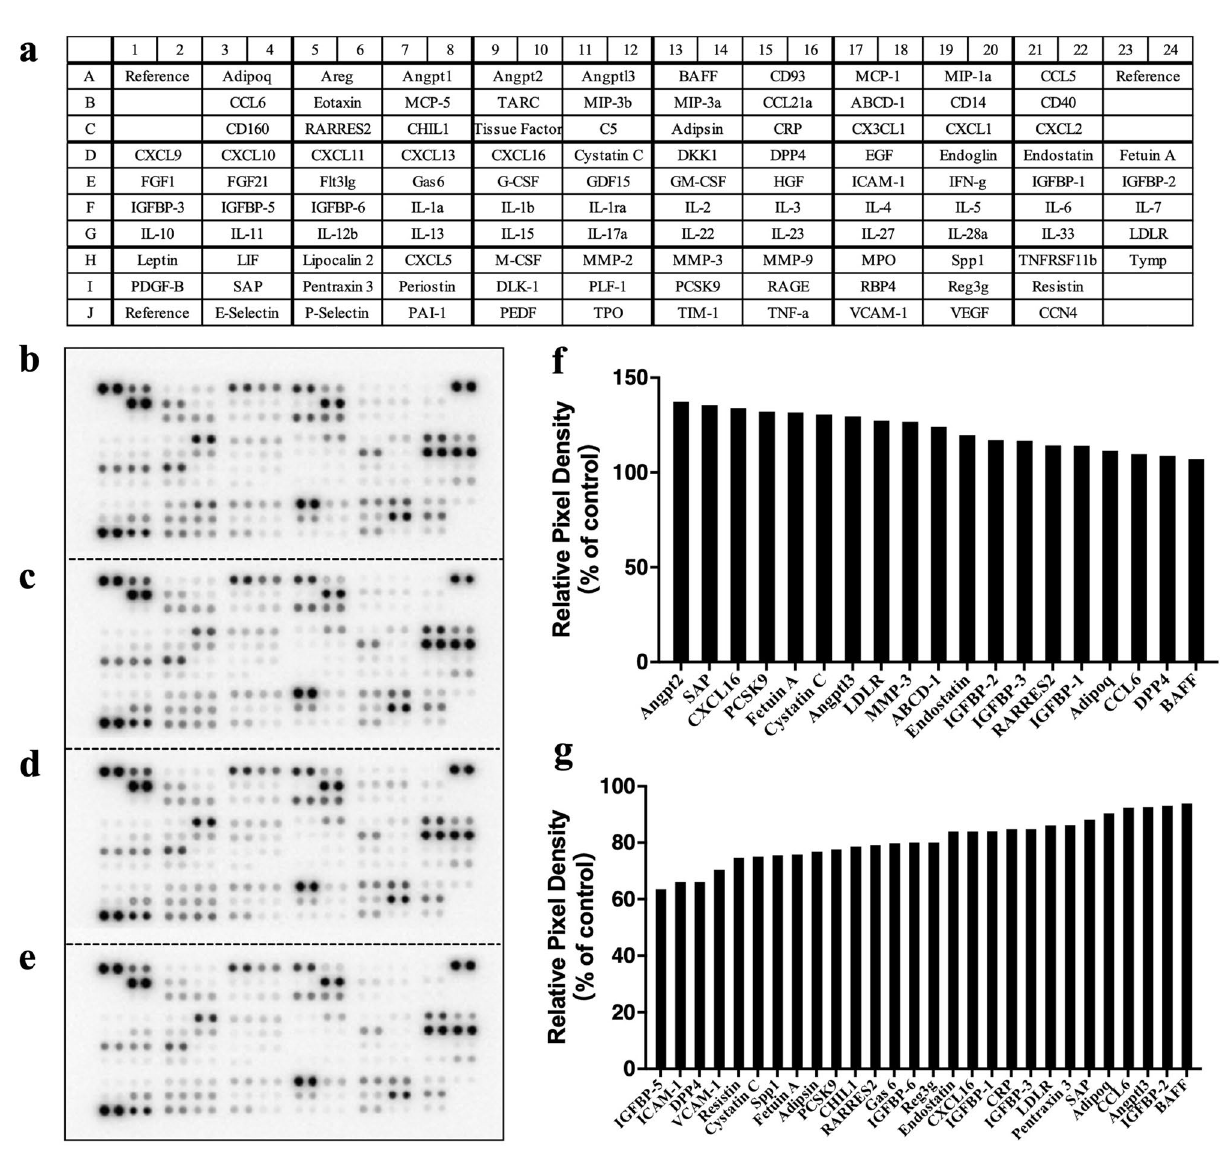
Figure 4. Cytokine array screening of mice serum infused with GIP_HUMAN[22–51] for 4 weeks. ( a ) Layout of antibody arrays and abbreviated names of the 111 cytokine/chemokine probes, adapted from the manufacturer’s information. ( b – e ) Complete hybridisation signals after probing with serum samples obtained from ApoE−/− mice infused for 4 weeks with saline alone ( b ), GIP_HUMAN[22–51] ( c ), combined infusion with GIP_HUMAN[22–51] and anti-GIP_HUMAN[22–51] IgG ( d ), or anti-GIP_HUMAN[22–51] IgG ( e ). ( f , g ) Quantified signal intensities of the respective serum proteins in mice infused with GIP_HUMAN[22–51] ( f ) or anti-GIP_HUMAN[22–51] IgG ( g ) in terms of 2-spot mean values relative to untreated experiments are